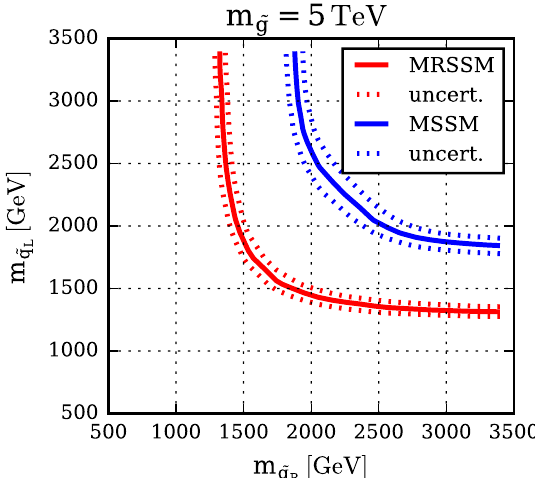
Figure 3 . Mass limits on left-/right-squark masses (assuming universality among generations) for m ˜ g = 5